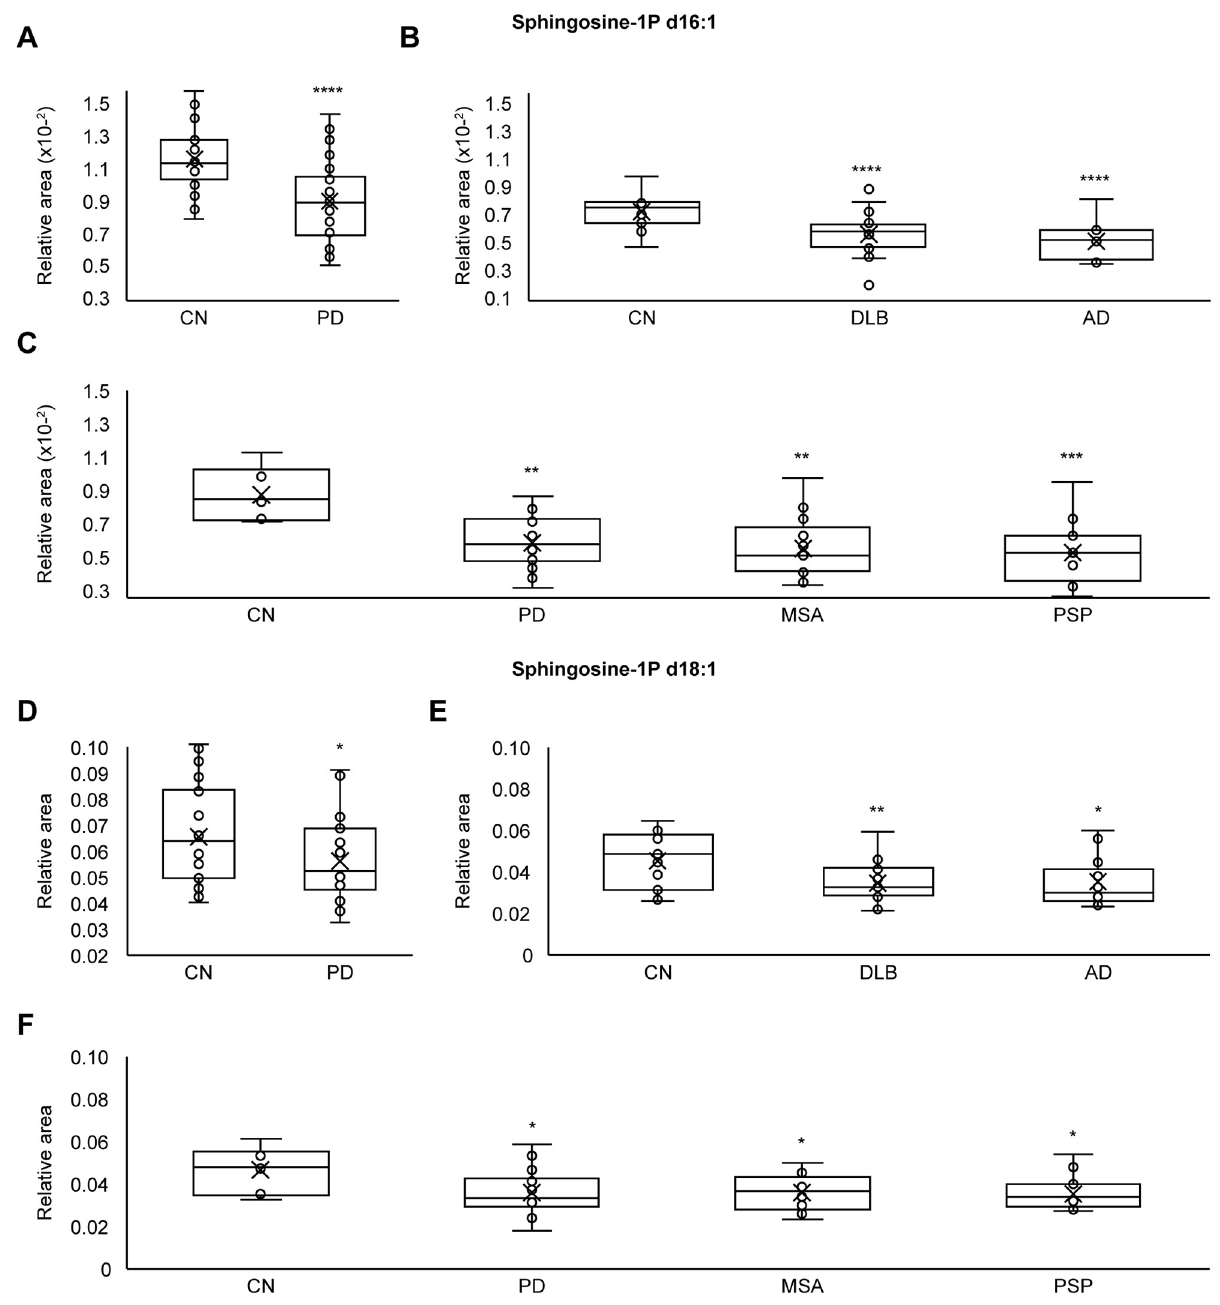
Fig 1. Plasma S1P levels in neurodegenerative diseases. (A) Plasma S1P d16.1 levels were significantly lower in the IPD group of cohort A (p < 0.0001) than in the CN group. (B) Plasma S1P d16.1 levels were significantly lower in the DLB group (p < 0.0001) and AD group (p < 0.0001) than in the CN group. (C) Plasma S1P d16.1 levels were significantly lower in the IPD group of cohort C (p < 0.01), MSA group (p < 0.01) and PSP group (p < 0.001) than in the CN group. (D) Plasma S1P d18.1 levels were significantly lower in the IPD group of cohort A (p < 0.05) than in the CN group. (E) Plasma S1P d18.1 levels were significantly lower in the DLB group (p < 0.01) and AD group (p < 0.05) than in the CN group. (F) Plasma S1P d18.1 levels were significantly lower in the IPD group of cohort C (p < 0.05), MSA group (p < 0.05) and PSP group (p < 0.05) than in the CN group. Statistical significance was examined using one-tailed Welch’s t tests (P < 0.05). Circles indicate the data points between the lower and upper whiskers, and x indicates the average marker in a box/whisker diagram.